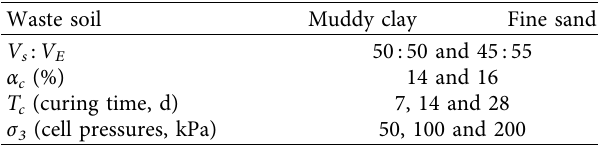
Table 4: The CU test